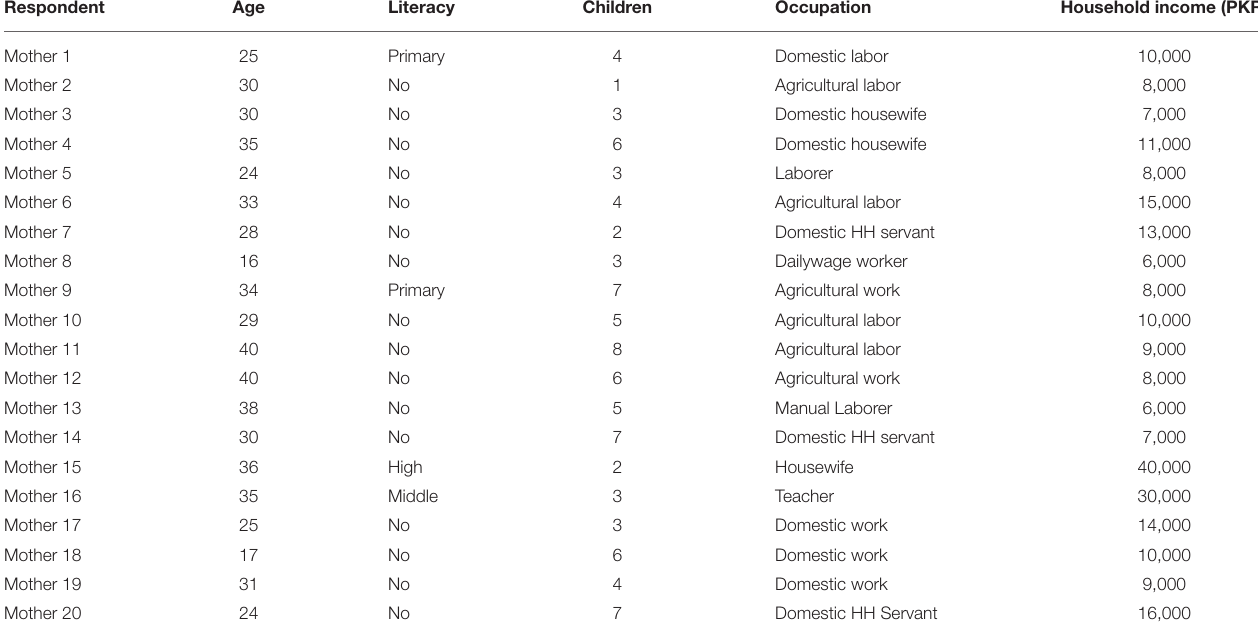
TABLE 1 | Respondents’ sociodemographic